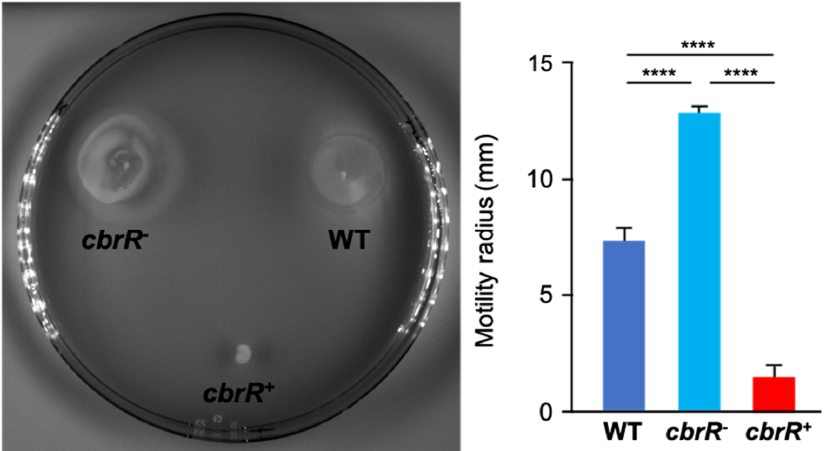
Figure 3. CbrR affects C. jejuni flagellar motility. Plate-grown C. jejuni WT, cbrR − , and cbrR + cells were inoculated into 0.4% ( w / v ) agar and incubated overnight. Motility was measured by the radius